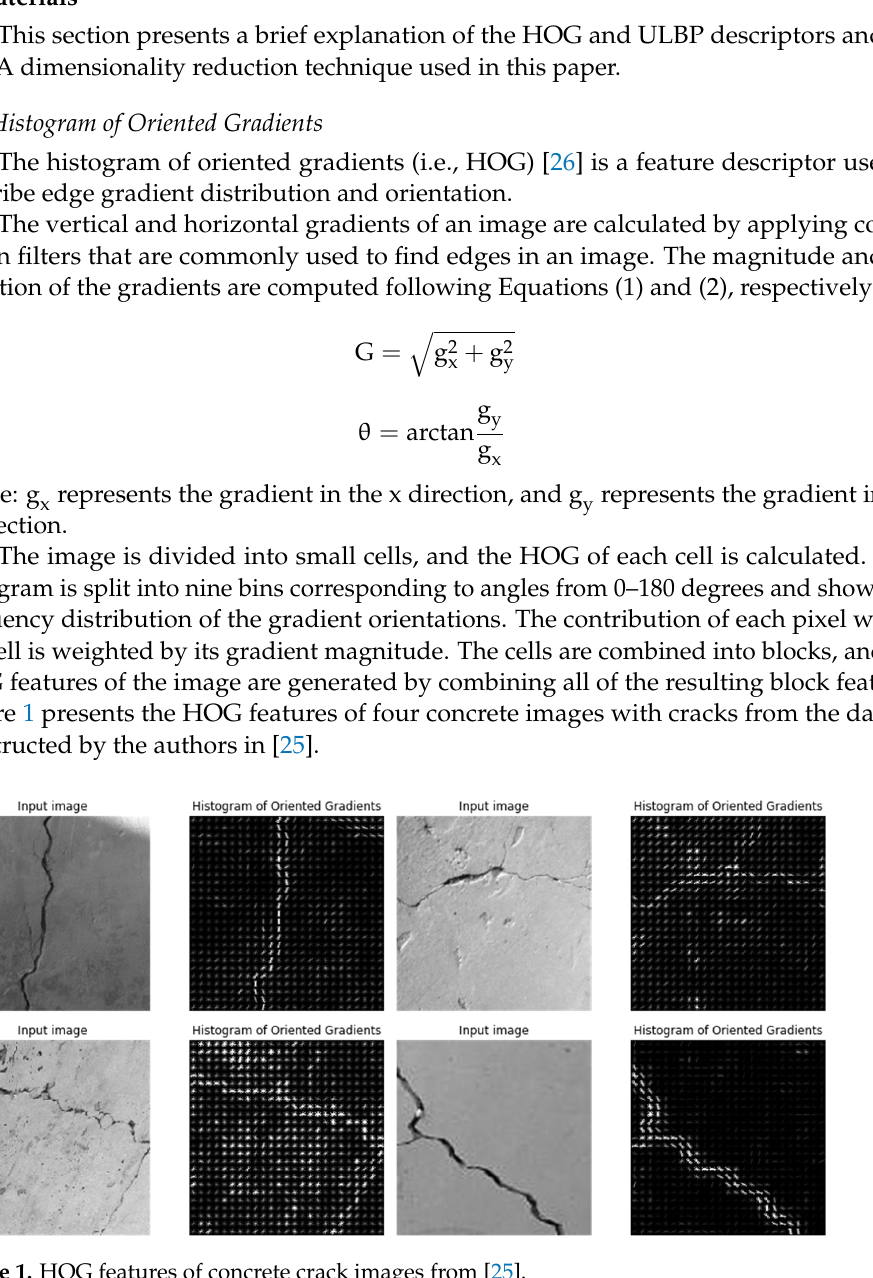
Figure 1. HOG features of concrete crack images from [25].